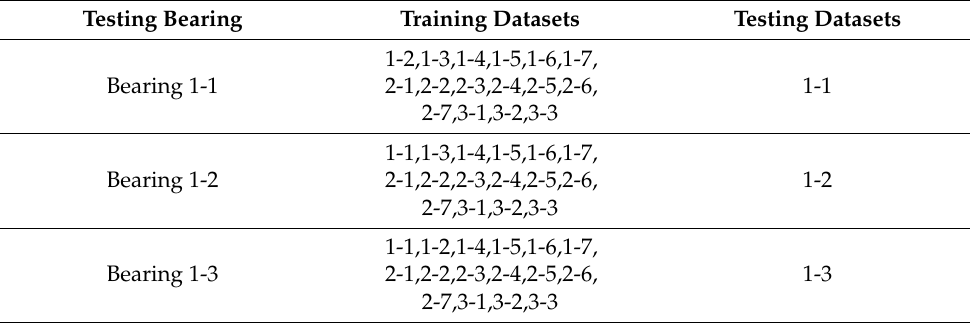
Table 3. The specific experimental arrangement in Test